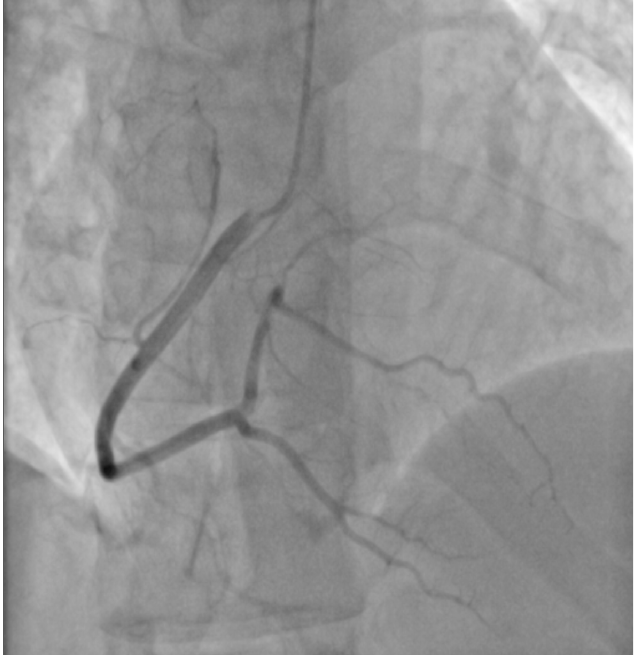
Figure 3. Cronarography (RAO straight projection). No lesions in the right coronary artery. A dual-chamber cardioverter-defibrillator (ICD DR, he did not consent to have subcu- taneous implantable cardioverter defibrillator) was implanted for the secondary prevention of sudden cardiac arrest and life-threatening ventricular arrhythmia (Figure 6). Antiar- rhythmic treatment was intensified: the dose of metoprolol succinate was increased from 25 mg to 50 mg